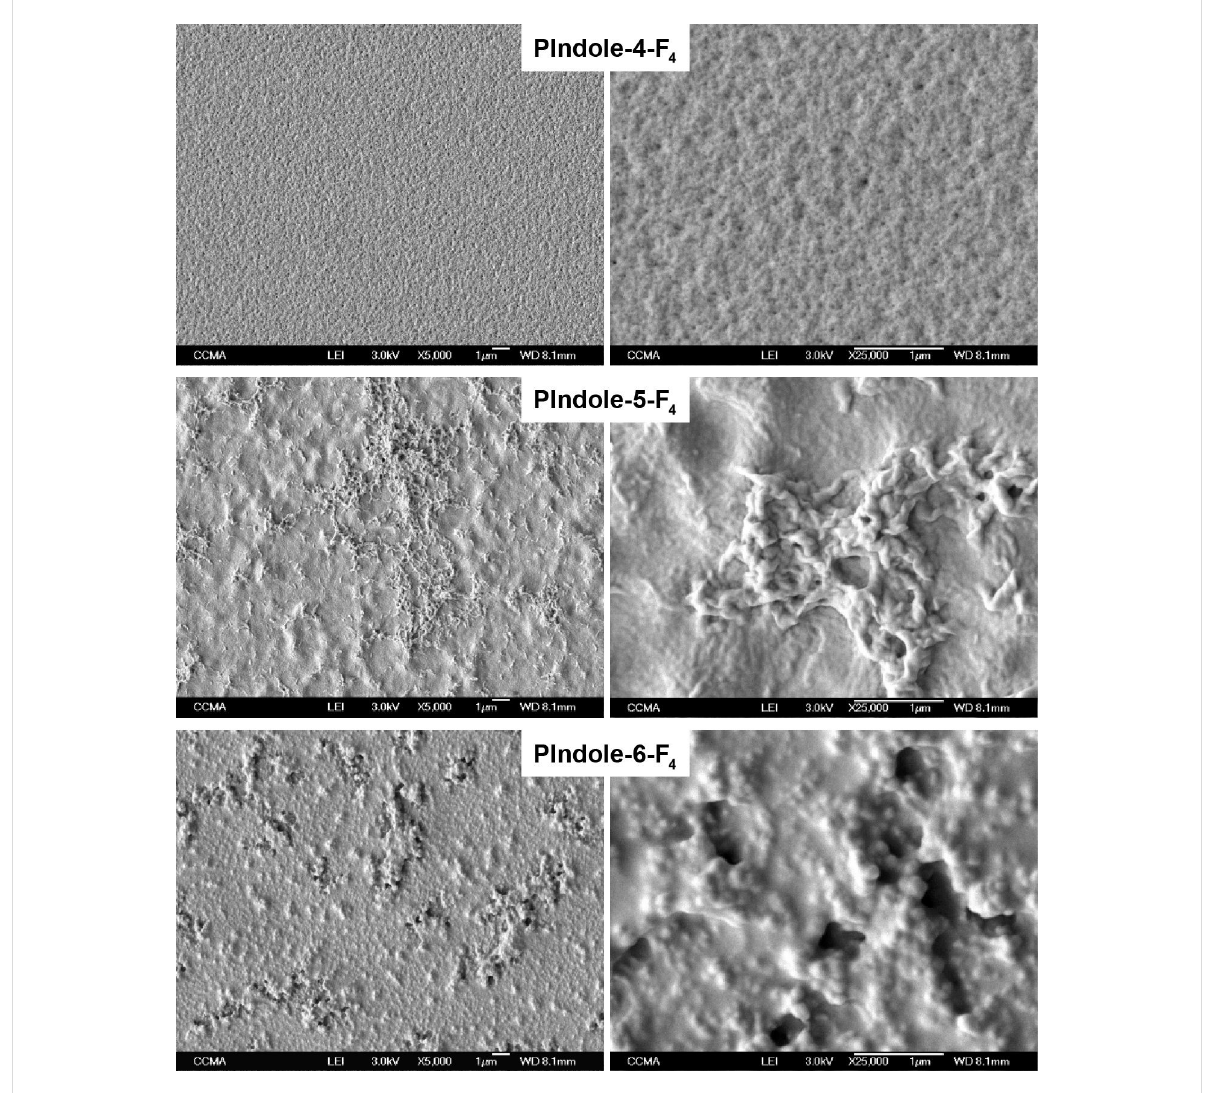
Figure 4: SEM images at two different magnifications (5000× and 25000×) of the polyindoles substituted with C 4 F 9 chains in the different positions.